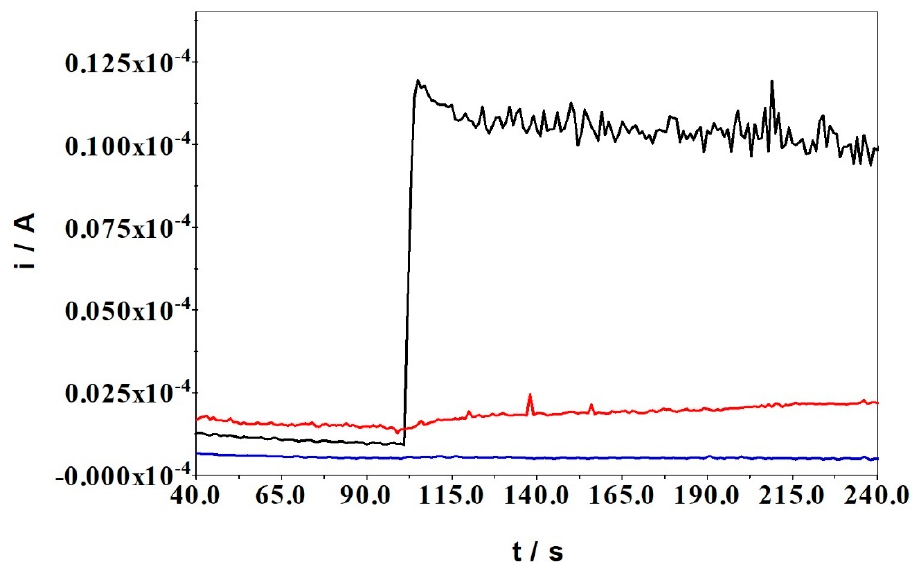
Figure 3. Amperometric response for: 0.64 mM cholesterol added in the mixture of: (black line) 2 mL chloroform-TBAP + 1 mL acetic anhydride + 40 µ L H 2 SO 4 , (red line) 2 mL chloroform-TBAP + 40 µ L H 2 SO 4 and (blue line) 2 mL chloroform-TBAP + 1 mL acetic anhydride.